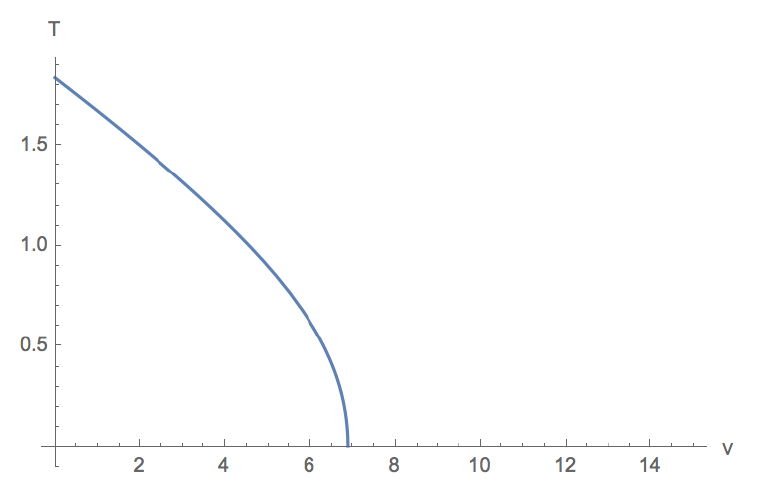
Figure 20 . Temperature of the black droplet as a function of (cid:23) for (cid:12)xed (cid:22) = 14 : 5. The temperature p goes to zero for (cid:23) = (cid:22) (cid:0) 2 (cid:22) (cid:25) 6 : 88.